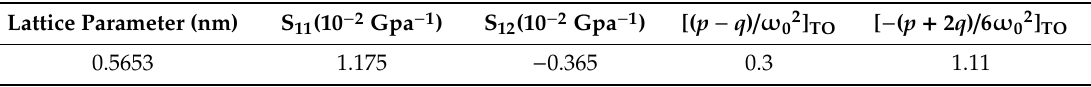
Table 3. The elastic parameters S 11 and S 12 of Si-doped GaAs and deformation potentials p , q for TO phonons used in the study. The parameters are cited from Reference [14]. Lattice Parameter